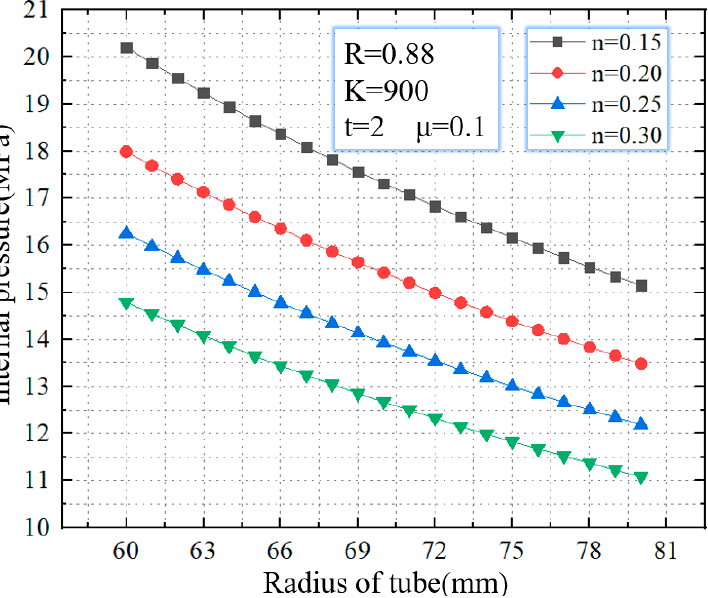
Figure 10. Critical internal pressure for rupture with different strain hardening exponents.